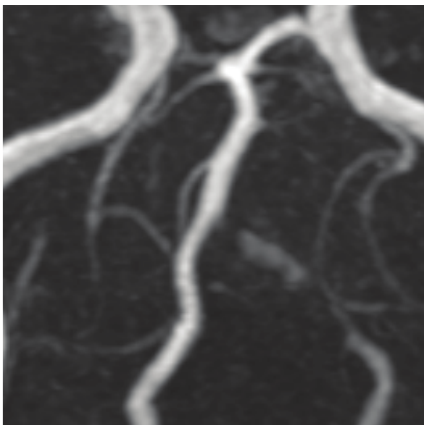
Figure 2: Follow-up MRA performed approximately 6 weeks after the first demonstrates progression of the stenosis of the left vertebralartery.Thefalselumenorintramuralhematomaisnowless